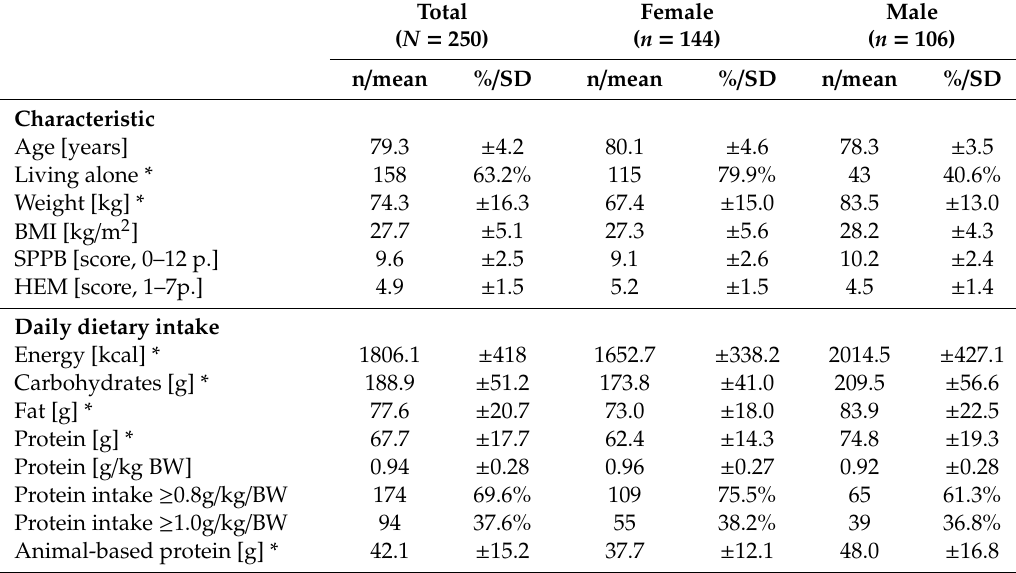
Table 1. Participants’ characteristics, HEM, and dietary intake for the total sample and separated by